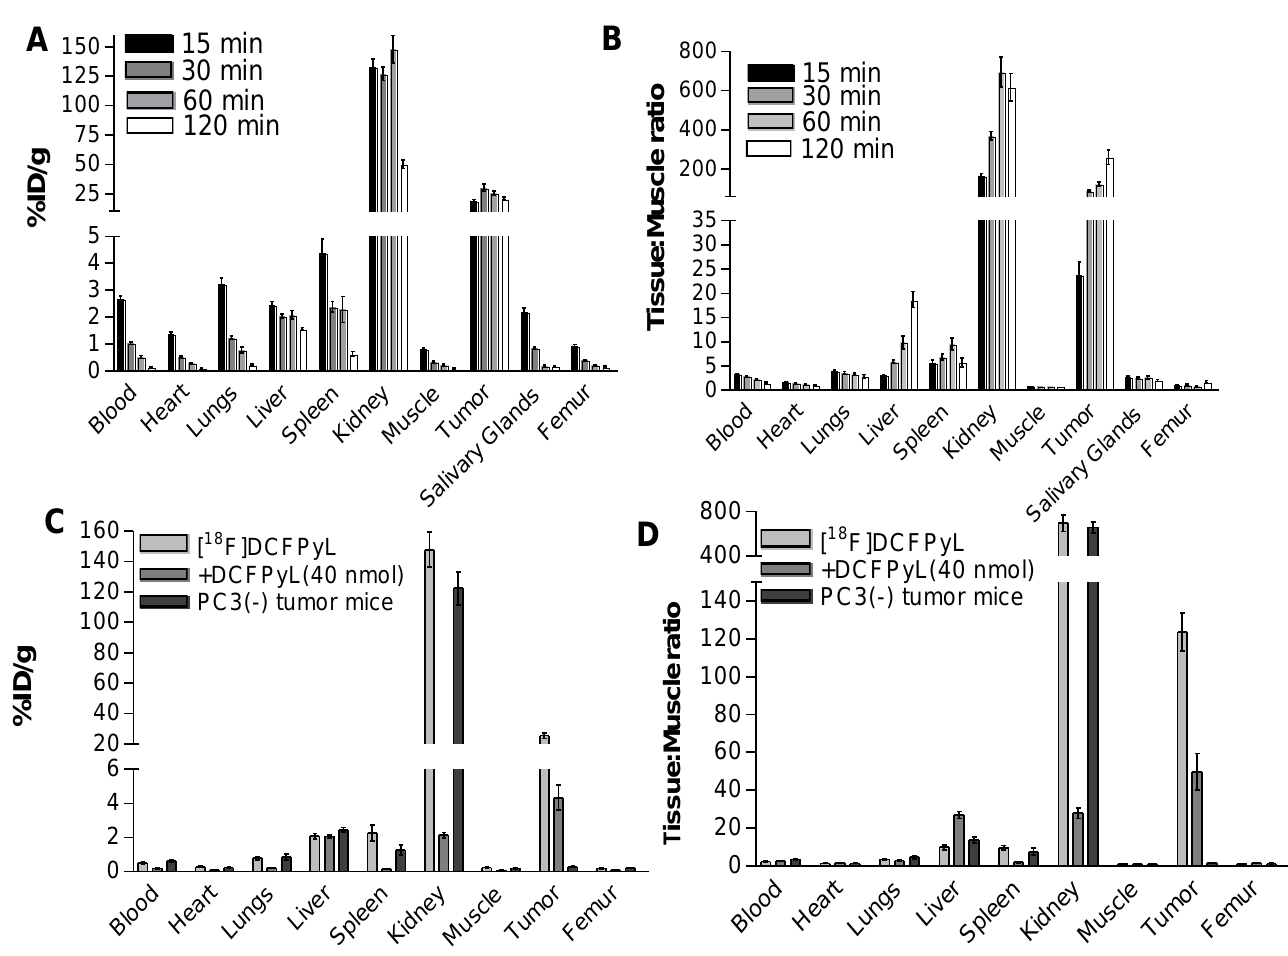
Figure 4. ( A ) Biodistribution [%ID/g (normalized to 20 g mouse)] of [ 18 F]DCFPyL in PC3(+) xenografts from 15 to 120 min. Each bar represents the mean %ID/g ± SE ( n = 8–10 per time point); ( B ) Tissue (%ID/g) to Muscle (%ID/g) ratios of [ 18 F]DCFPyL in PC3(+) xenografts from 15 to 120 min. ( C , D ) Biodistribution [%ID/g (normalized to 20 g mouse); Tissue (%ID/g) to Muscle (%ID/g) ratios (T:M)]of [ 18 F]DCFPyL at 60 min in PC3( − ) xenografts and PC3 (+) xenografts injected with [ 18 F]DCFPyL only or coinjected with DCFPyL (1000 × ; 40 nmoles). Each bar in the graph represents the mean (%ID/g or T:M) ± SE ( n = 8–10 per group). Additional [ 18 F]DCFPyL biodistribution studies at 60 min were carried out with PC3( − ) xenografts and PC3(+) xenograft groups that received [ 18 F]DCFPyL alone or a coinjection with a blocking dose of non-radioactive DCFPyL [1000 × ; 40 µ g] (Figure 4C,D). The biodistributions of the PC3( − ) xenografts were comparable to the PC3(+) xenografts for the blood and all tissues except for the PC3( − ) tumors (0.3%ID/g) which represented <2% of the uptake observed in PC3(+) tumors (25.6%ID/g). In the blocking studies with the PC3(+) xenografts, the group receiving DCFPyL exhibited >50% reduction in blood and most tissue uptakes (%ID/g) compared to the [ 18 F]DCFPyL- only group. T:Ms were calculated to take into account these alterations in the input function and metabolism caused by the DCFPyL blocking dose. The PC3(+) tumor T:M (50:1) of the blocked group was significantly decreased (60%) compared to the [ 18 F]DCFPyL-only group (141:1 T:M; p < 0.0001). This blocking taken together with the lack of uptake in PC3( − ) tumors